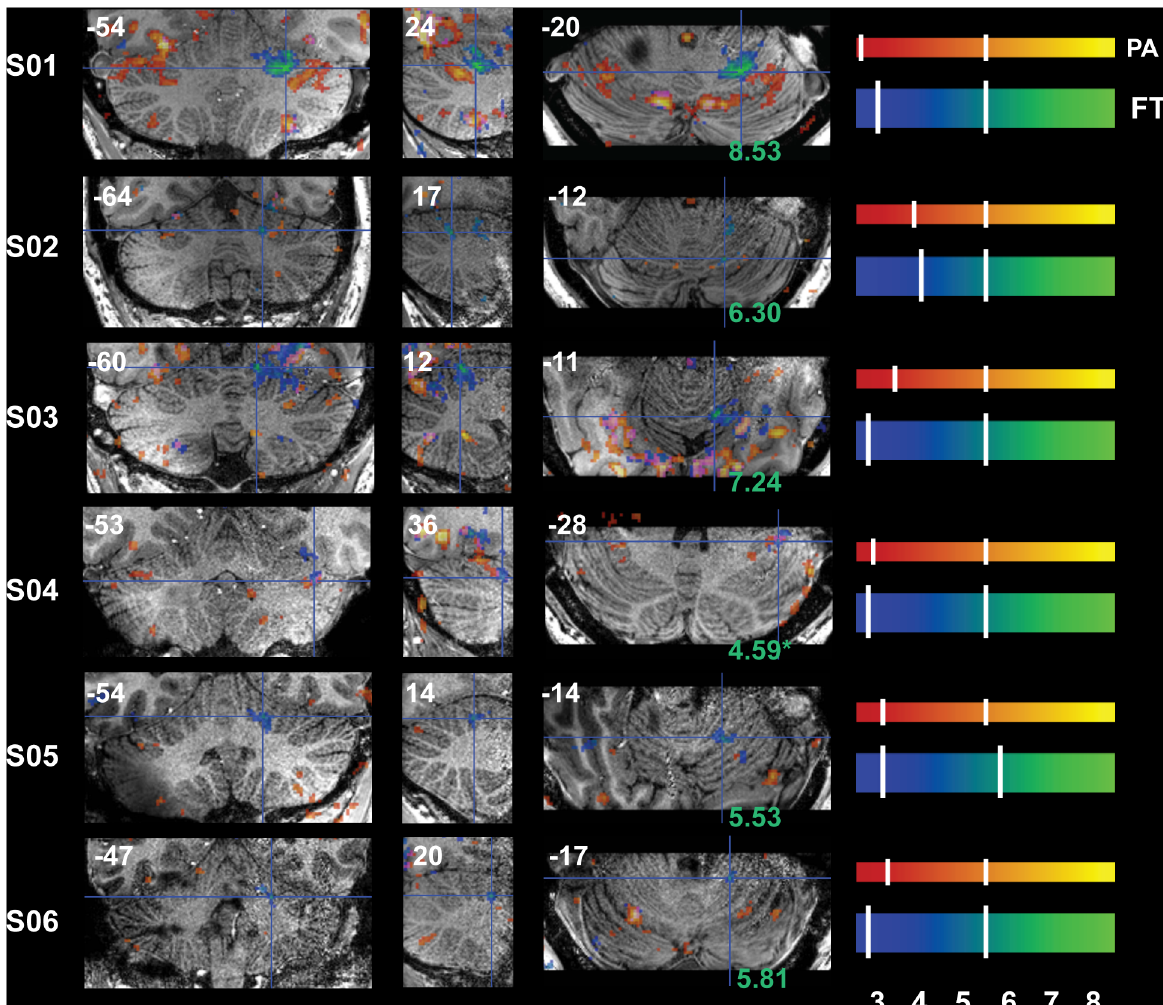
Fig 4. Functional Accuracy of Thumb Tapping Activations in Cb, Ipsilateral IV-VI. Ipsilateral h IV - VI is activated during the FT task; crosshairs denote an active cluster in or adjacent to right h V (S04 – h VI-VII). Activations for both tasks are shown in all images, with PA activity denoted by red-yellow and FT activity by blue-green color bars. Note the large structural and functional (with regard to both location and strength) variability between subjects; maximum FT-clusters can be located anywhere between the IV-V border (S03, S05 and S06) to the V-VI border (S01, S02, S04). Slice locations (in non-normalized MNI space) are displayed at the top of each panel and T-values at the crosshairs are displayed at the bottom of the axial (rightmost) panels. Refer to Fig 1a for a guide to anatomical lobule definitions.